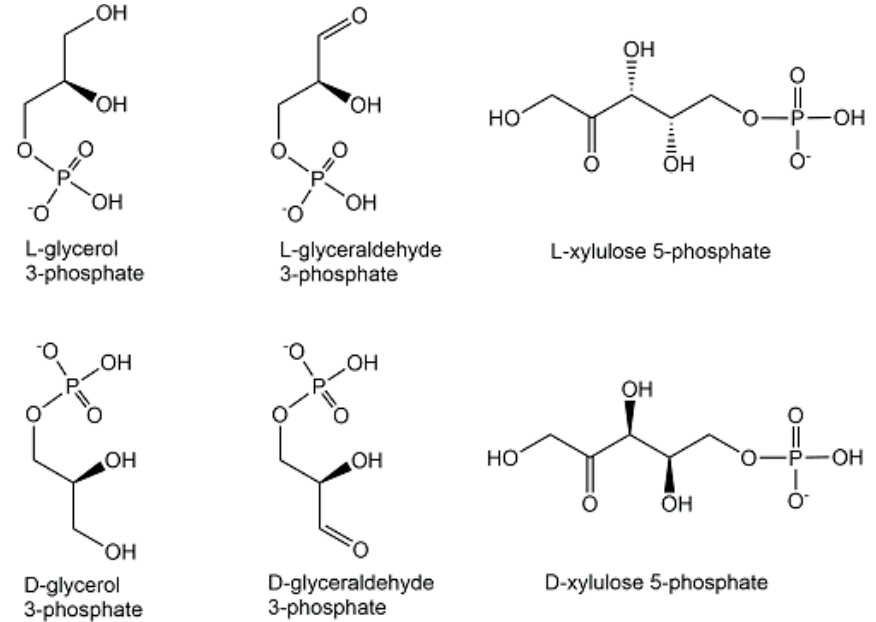
Figure 7. Enantiomers of terminally phosphorylated glycerol, glyceraldehyde, and xylulose.